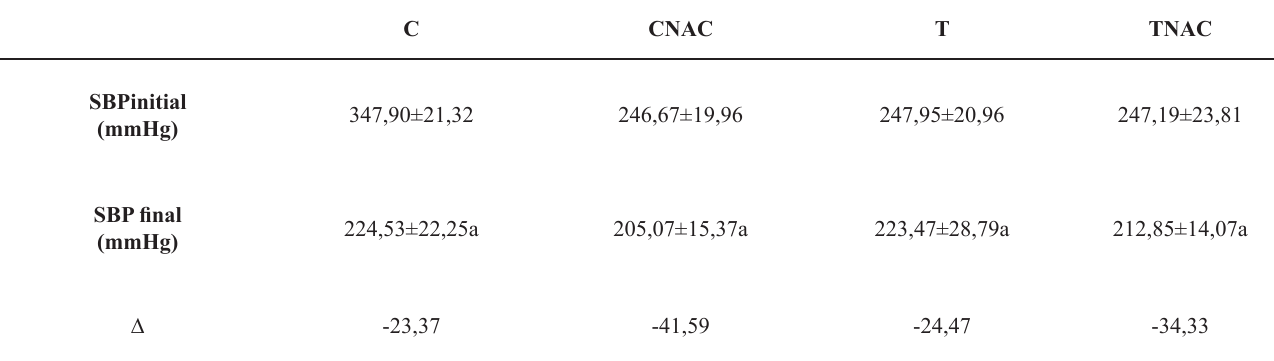
Table 5. Systolic Blood Pressure (SBP) at the beginning and end of the experiment.